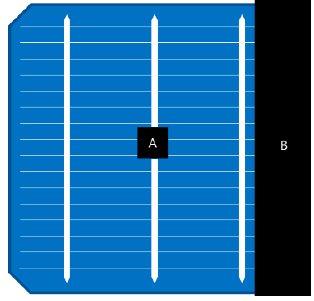
Figure 4. Vertical shading of a c-Si solar cell.